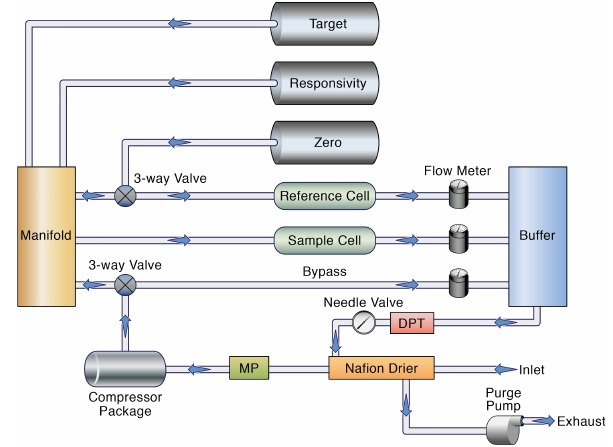
Fig. 3. Air flow for RM0 continuous analyzer. Note that there are feedbacks loops between proportional valves (not shown) and the three flow meters and pressure transducer of the buffer volume. MP is the chemical drier filled with Magnesium Perchlorate. DPT is the dew point temperature